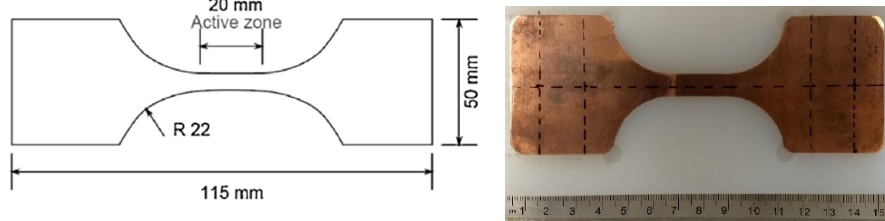
Figure 4. Dimensions of the coil prepared for the EM joining process (5 mm thickness).